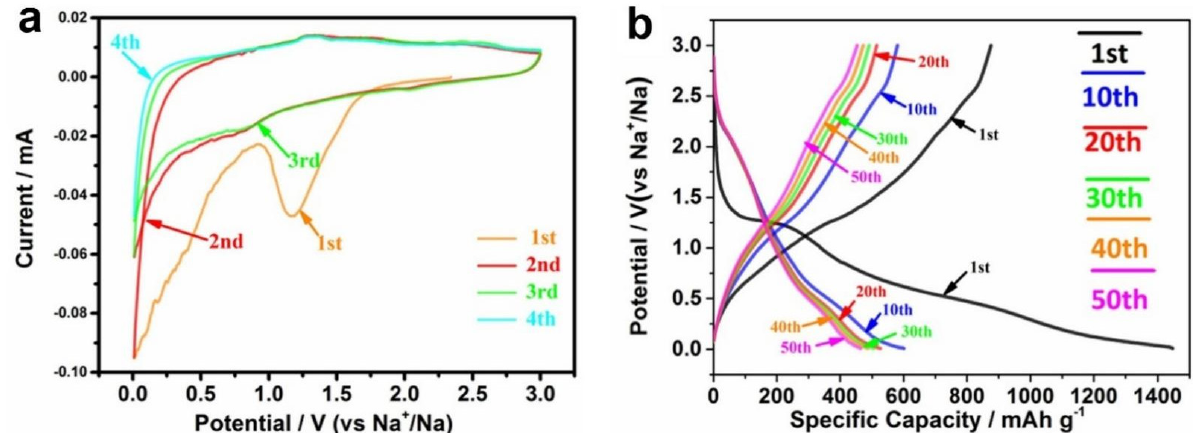
Figure 7. ( a ) CV of Fe 2 O 3 /SNRGO electrode, ( b ) GCD curves for the 1st, 10th, 20th, 30th, 40th and 50th cycles of Fe 2 O 3 /SNRGO electrode at 0.1 A g − 1 . Reproduced with permission [56]. Copyright 2020, Elsevier.